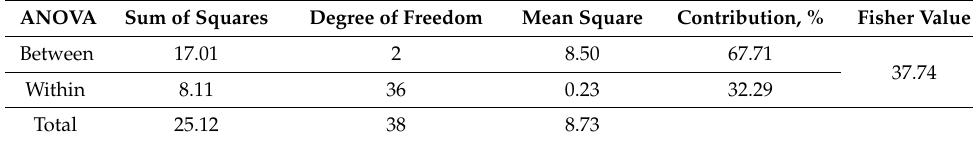
Table 5. Comparison between Groups A, B and C in T1-T2.